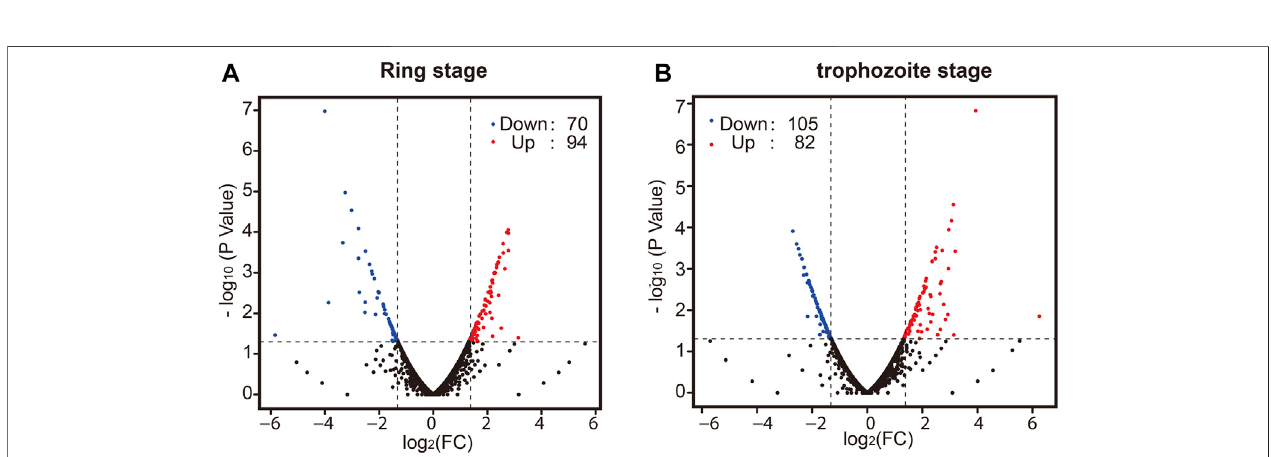
FIGURE 3 | The effect of temperature on the development of parasites in the ring stage and trophozoite stage. Pair-wise comparisons between Plasmodium cultures. Volcano plot of log 2 fold change in gene expression in the 26 ° C treatment group versus the 37 ° C control group that differs signi fi cantly (|log 2 ratio| ≥ 1 and q -value|FDR ≤ 0.05) in the ring stage (A) and trophozoite stage (B) . Red plots indicate genes upregulated in the 26 ° C treatment group compared to the 37 ° C control group; blue plots indicate genes downregulated in the 26 ° C treatment group compared to the 37 ° C control group; and black plots indicate genes that are not signi fi cantly different between the two groups. A full list of differentially expressed genes for each condition is shown in Supplementary Table S3 .